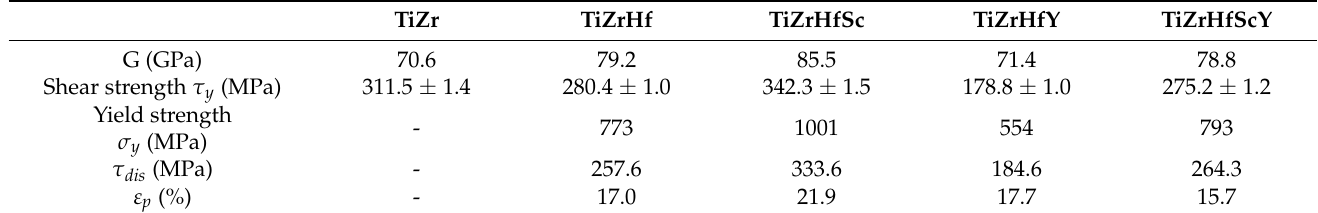
Table 4. Comparisons on the shear modulus G determined by first-principles calculation, shear strength τ y predicted by kink-dislocation model, ductility ε p and yield strength σ y obtained from experimental measurements [16], and dislocation shear strength τ dis = σ y /3 for HCP CSAs. TiZr TiZrHf TiZrHfSc TiZrHfY TiZrHfScY